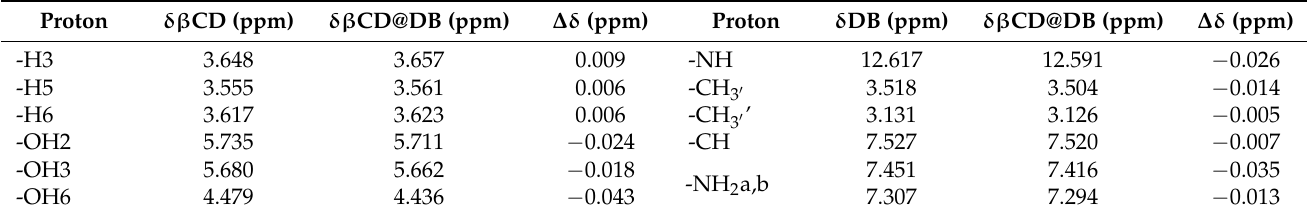
Table 1. Proton assignments and 1 H-NMR chemical shifts of β CD, DB, and β